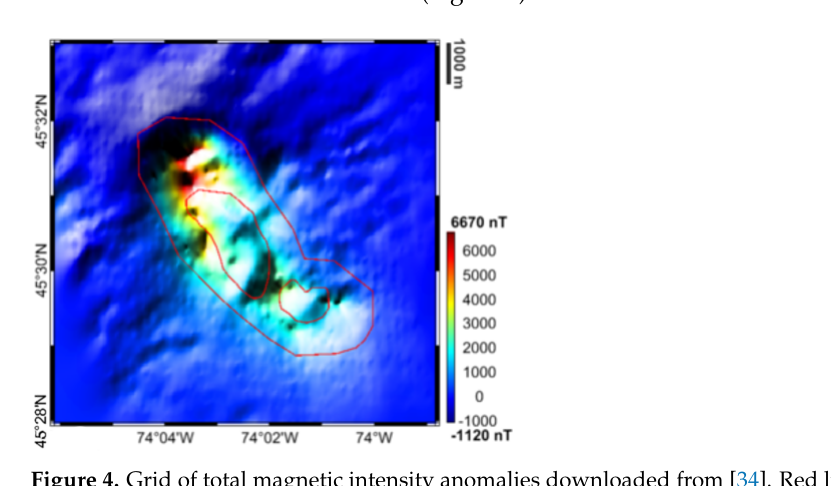
Figure 4. Grid of total magnetic intensity anomalies downloaded from [34]. Red lines represents the boundaries of main units of the Oka